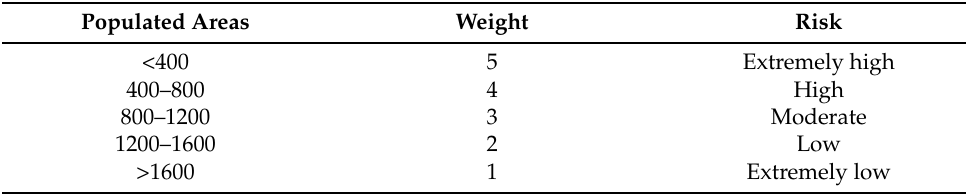
Table 9. Fire risk classification of distance to populated